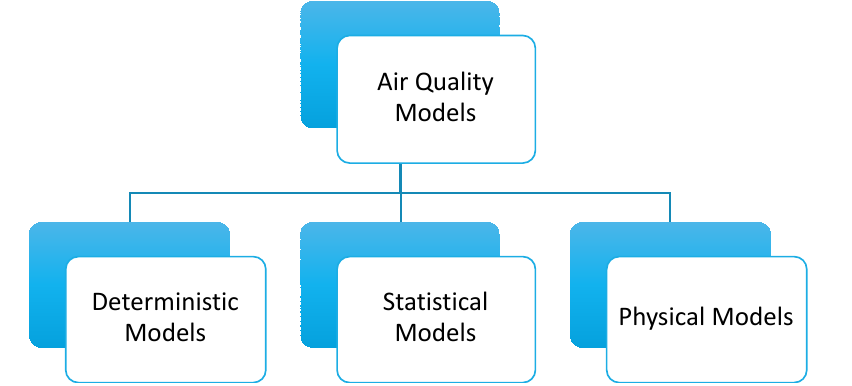
Figure 1. Classification of Air Quality Models [18].